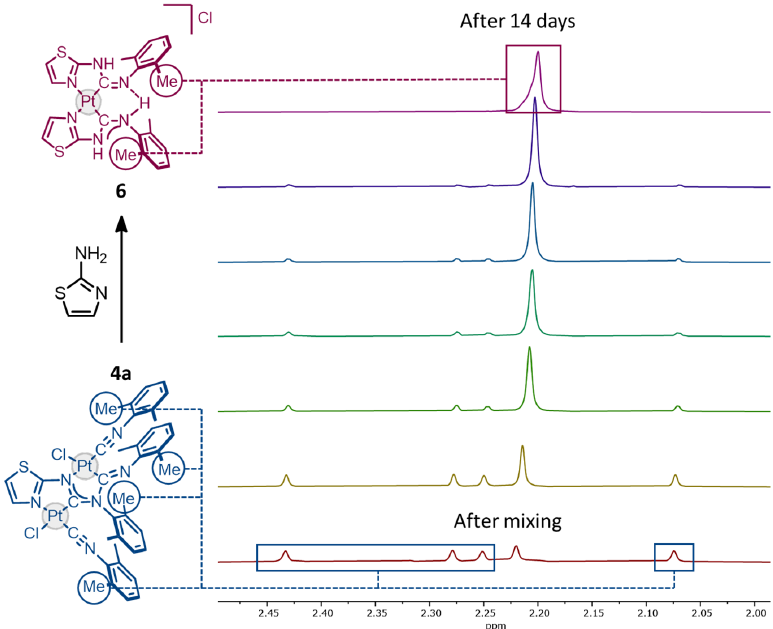
Figure 2. 1 H NMR monitoring of the reaction mixture with 1 / 2 ratio = 1:5 at RT.